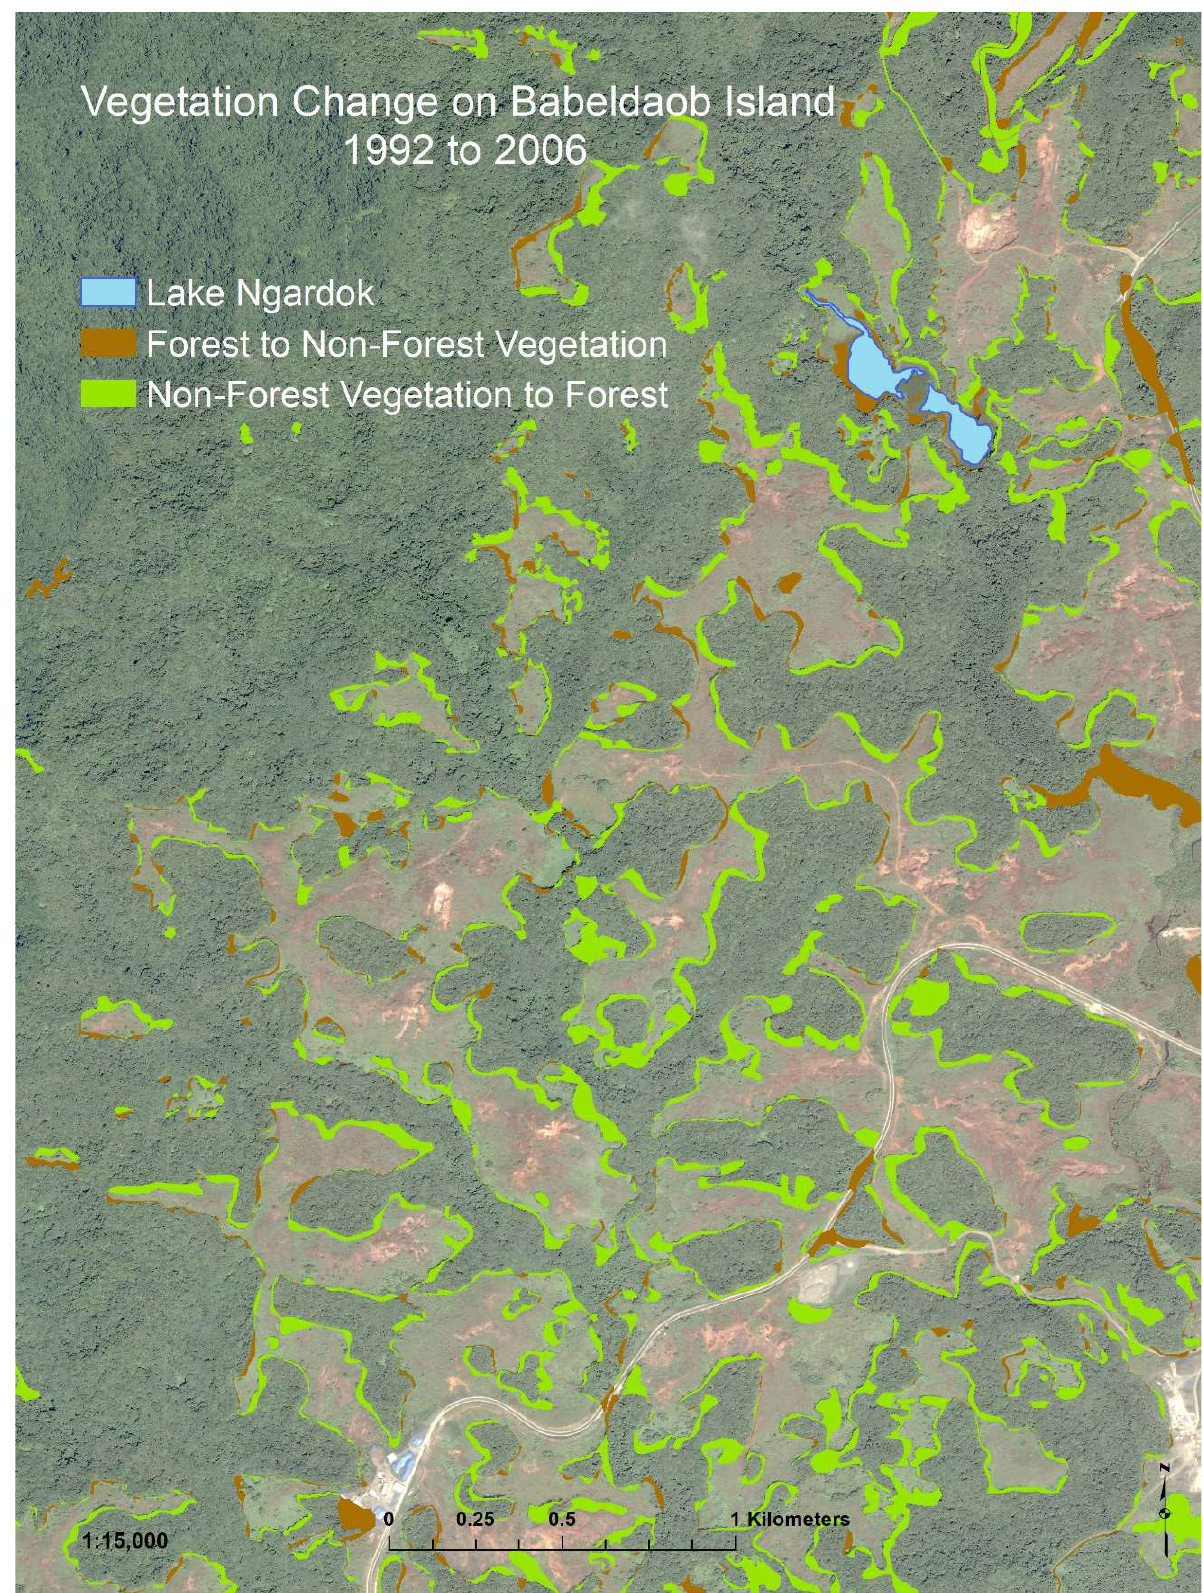
Figure 6. A 10× zoom view of Babeldaob Island, Palau showing forest and non-forest vegetation cover changes in the area south of Lake Ngardok in Melekeok State between 1992 and 2006, overlaying the Quickbird satellite image base map.